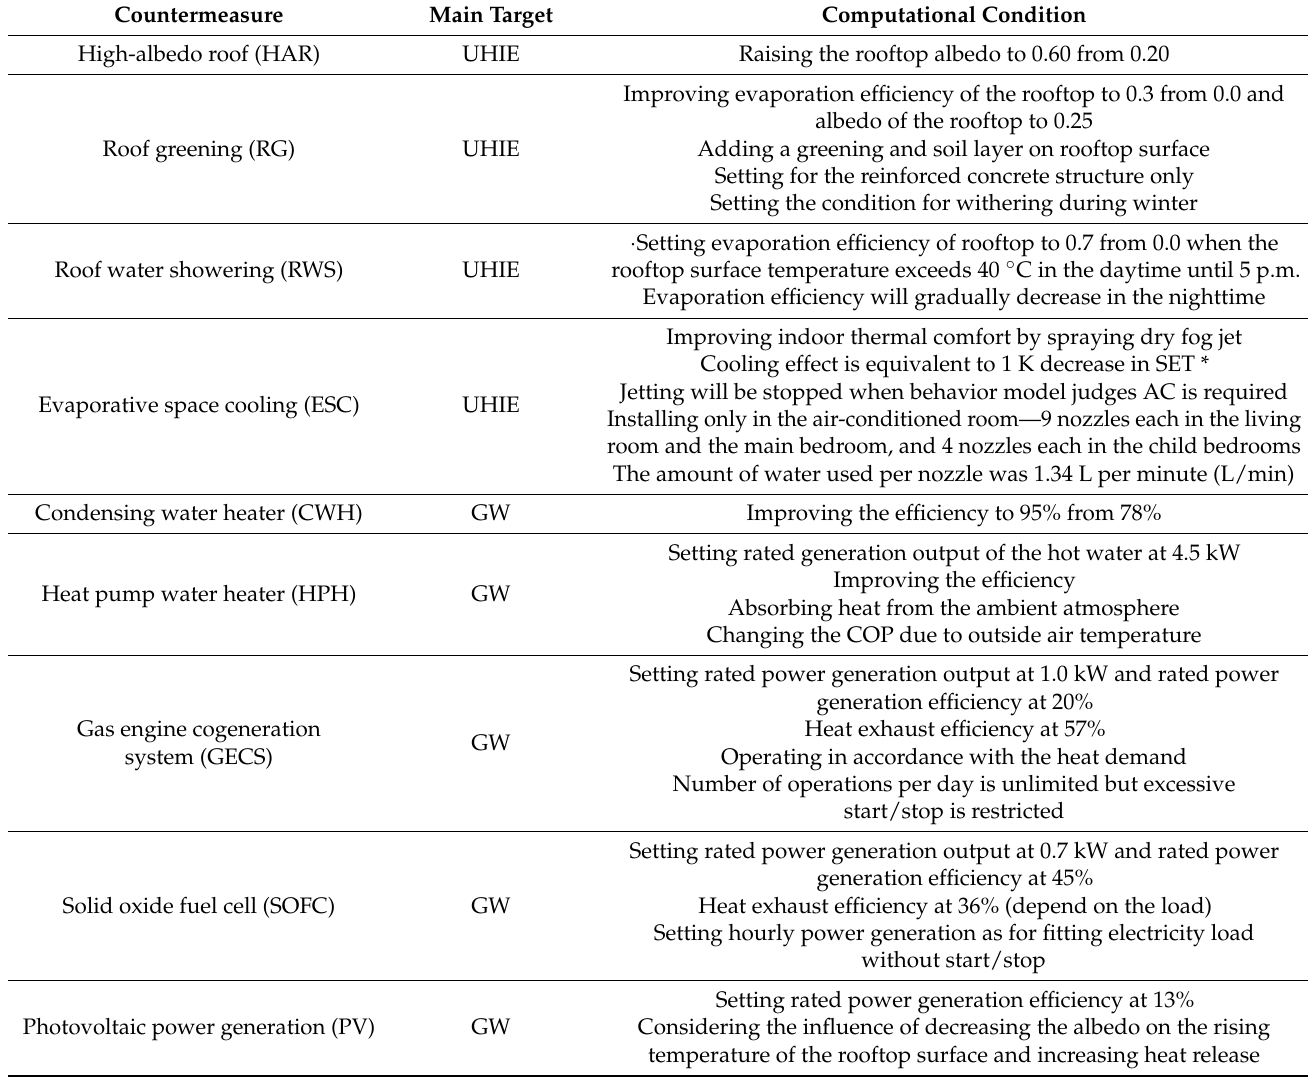
Table 3. Outline of the evaluated